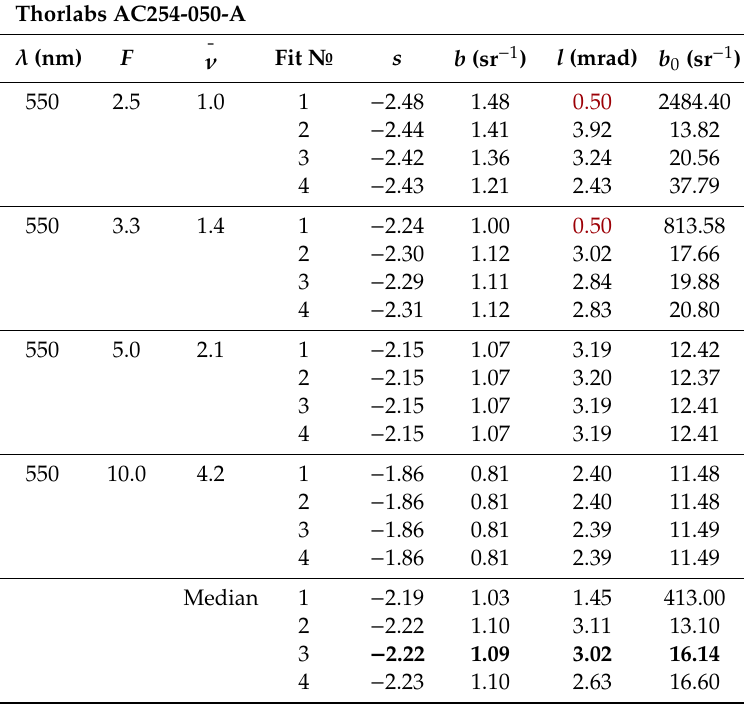
Table A8. Fit results for the lens Thorlabs AC254-050-A. Thorlabs